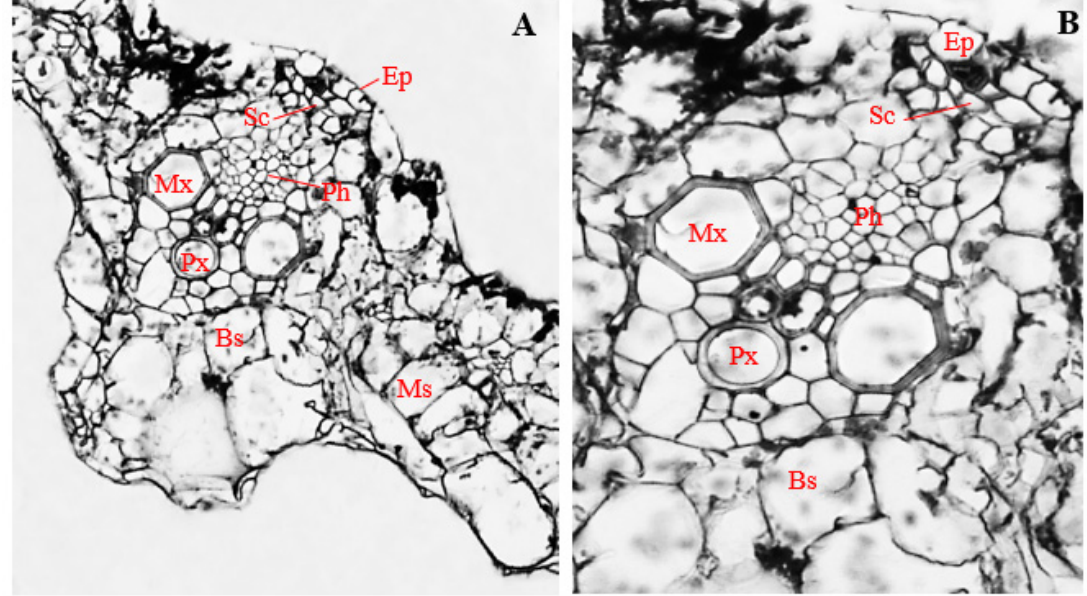
Figure 10. Transverse section of corn leaf infected with endophytic Fusarium verticillioides . ( A ) Mag- nification 200×; ( B ) magnification 400×. Ep, epidermis; Sc, sclerenchyma; Ph, phloem; Mx,